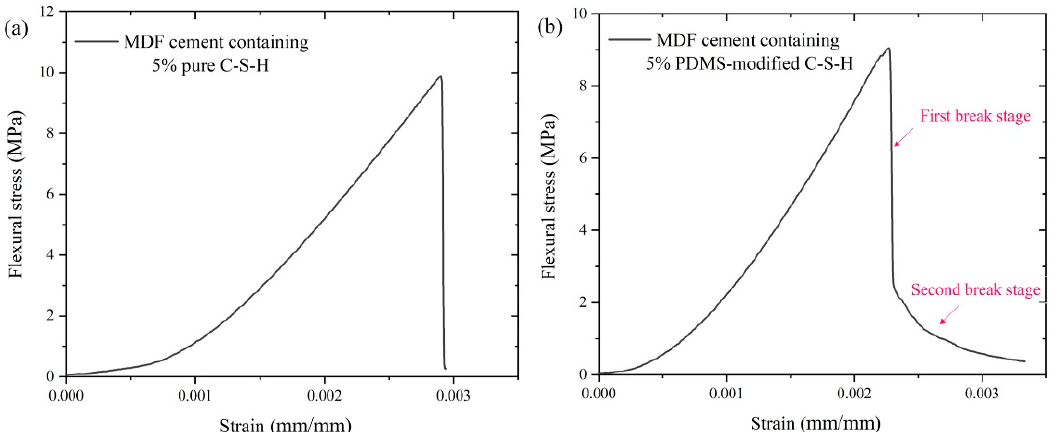
Figure 2. Flexural strength–strain curves for MDF cement containing: ( a ) 5% PDMCSH00; ( b ) 5% PDMCSH50.